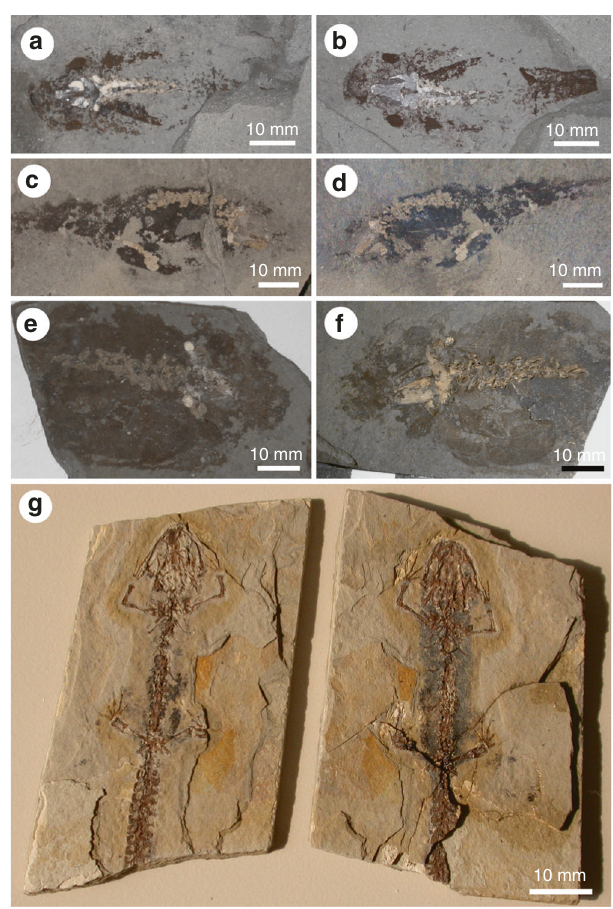
Fig. 5 Distribution of soft tissues in part and counterpart of fossil amphibian specimens. In a – f the plane of splitting passes medially through the soft tissues, thus exposing non-integumentary melanosomes at the surface and producing near-identical distributions of soft tissues in part and counterpart.